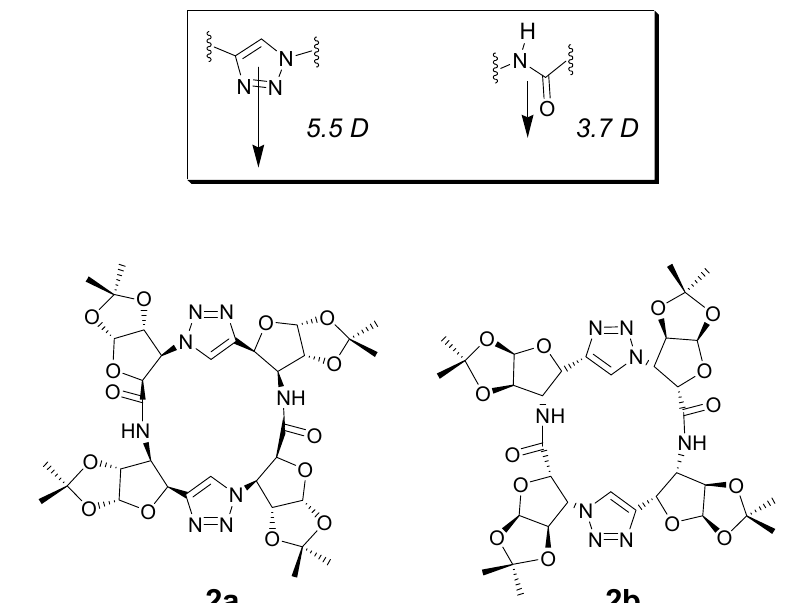
Figure 3. Comparison between triazole and amide functionalities, and diastereoisomeric rotamers of macrocycle 2. For the comparison between dipole moments, see Ref. [37].